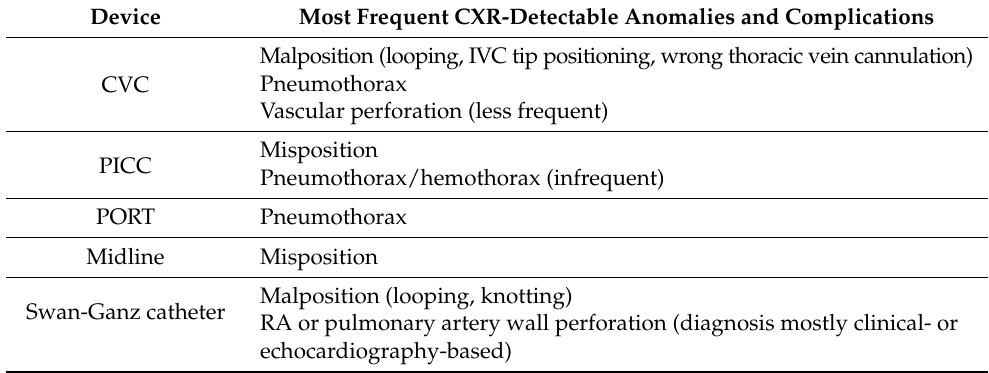
Figure 5. A detail of a CXR showing a left jugular CVC looping with tip ending in the left jugular vein (green circle). Note that due to the underexposure of the CXR, the device is difficult to detect.